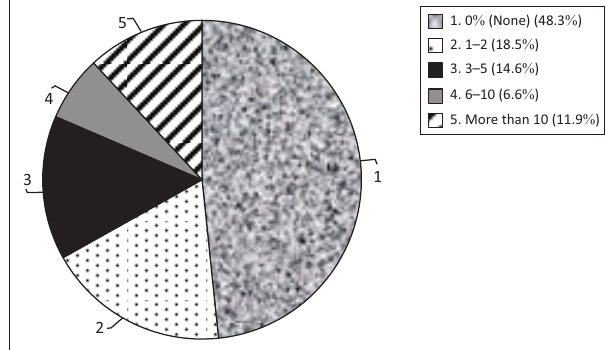
FIGURE 10: Extent to which businesses have established foreign